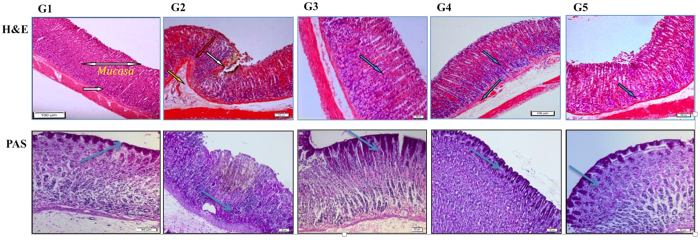
The histological effect of MDLA on gastric mucosal (H&E) and gastric tissue glycoprotein-PAS staining in HCl/Ethanol induced gastric ulcer in rats.(G1) (Normal control group); Rats in group 1 have no disruption of the surface epithelium. (G2) (Ulcer control group); Rats in group 2 have severe disruption of the surface epithelium (red arrow) and necrotic lesions that penetrate deeply into the mucosa (white arrow). Extensive edema of the submucosal layer (yellow arrow) and leukocyte infiltration are present (yellow arrow). (G3) (omeprazole); Group 3 has mild disruption of the surface epithelium, and there is a submucosal edema and leucocyte infiltration (blue arrow). (G4) (MDLA 10 mg/kg); Group 4 has moderate disruption of the surface epithelium with edema and leucocytes infiltration of the submucosal layer (blue arrow). (G5) (MDLA 20 mg/kg); Rats in group 5 showed a mild disruption of the surface epithelium with edema and leucocyte infiltrationin submucosal layer (blue arrow) (H&E staining, 20×). The gastric mucosa in animals pretreated with MDLA or omeprazole (group 3–5) displayed increased PAS staining intensity compared to the rats in group 2, indicating an increase in the glycoprotein content of gastric mucosa in pretreated rats (blue arrows) (PAS stain 20×).